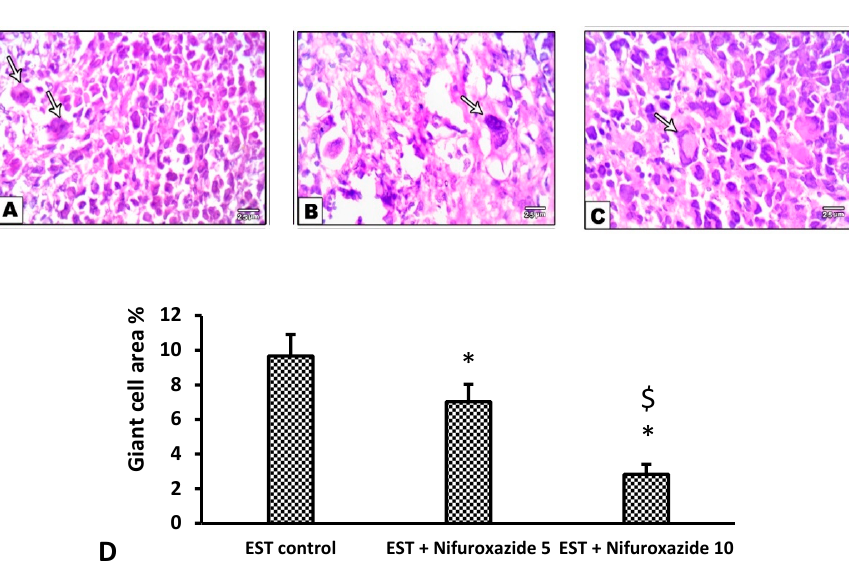
Figure 9. Microscopic pictures of H&E stained sections from tumor masses showing giant cells. Extensive areas of giant cells (arrows) appear in the EST group ( A ), while giant cells were decreased in the EST + Nifuroxazide 5 mg/kg groups ( B ). A marked reduction in the giant area was observed in group treated with EST+Nifuroxazide 10 ( C ). X: 400. ( D ) Column chart for giant cell area percentage, data are mean ± S.D. and compared by one-way ANOVA and Bonferroni’s test at P less than 0.05. * Versus the EST control, $ Versus the EST + Nifuroxazide (5 mg/kg) group. EST: Ehrlich solid